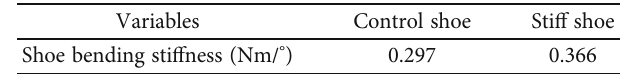
Table 1: Shoe bending sti ff